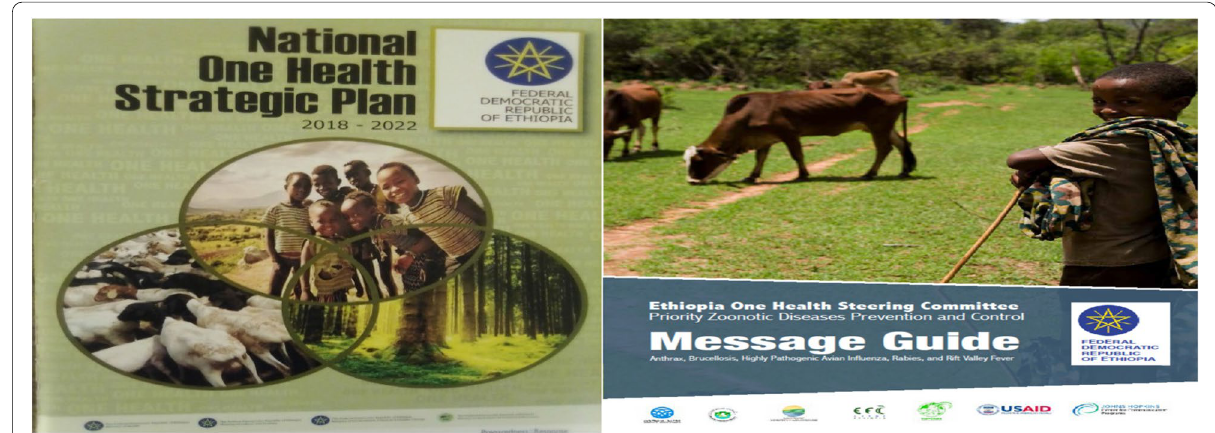
Fig. 4 The National One Health Strategic Plan and Its Communication Message Guide taken from NOHSC with